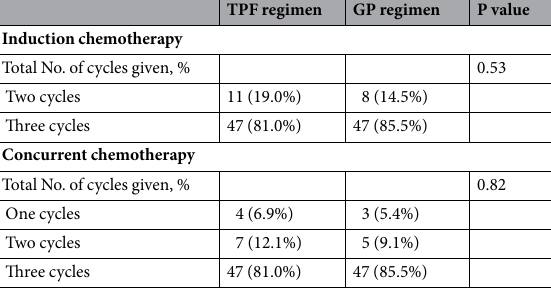
Table 2. The detail compliance of IC and concurrent chemotherapy between two arms.